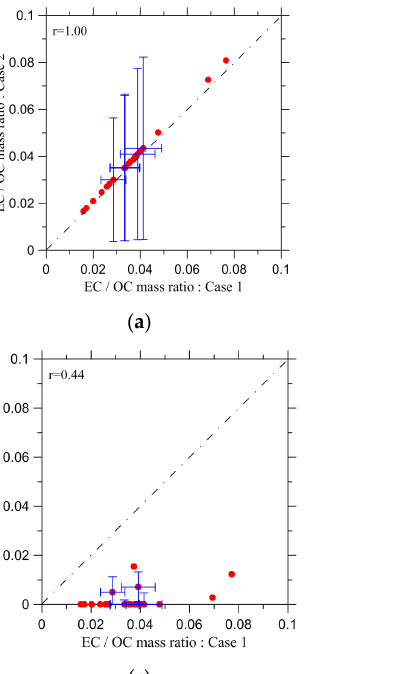
Figure 5. The relationships between the estimates of the EC/OC mass ratio for different cases (( a ) Case 1 and Case 2, ( b ) Case 1 and Case 3, ( c ) Case 1 and Case 4 and ( d ) Case 3 and Case 4) of the estimation procedure. Error bars show the 90% confidence intervals representing the uncertainty of the approximations, but not comprising possible measurement errors. Note that the error bars are shown only for a part of the data points to ensure the readability of the plots. Note also that where Equation (2) yielded unphysical negative values for the Case 4 estimates, the EC/OC ratio for that case was assumed to be zero. The dot-dashed lines indicate the 1:1 ratios. Also indicated are values of the Pearson’s correlation coefficient,